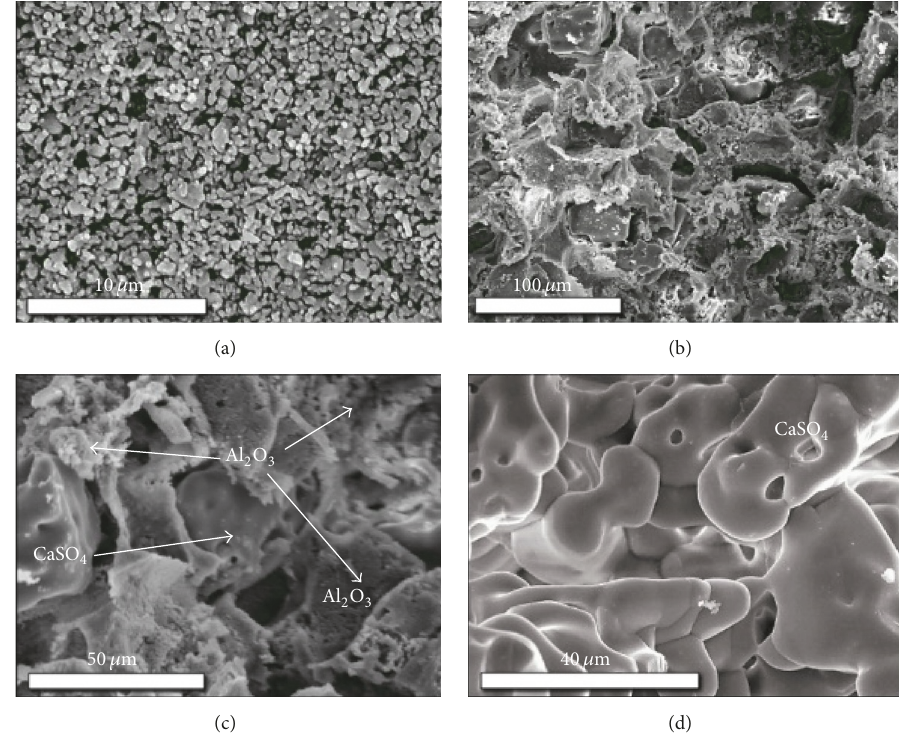
Figure 7: SEM images and EDX data of Al 2 O 3 -impregnated samples following procedure 2 (Table 1) with 30s of impregnation time. (a) SEM image of surface of the covered 3D structure. ((b) and (c)) SEM image showing a good distribution of Al 2 O 3 inside the porous structure. (d) SEM image of the inner part of the supporting CaSO 4 porous structure.